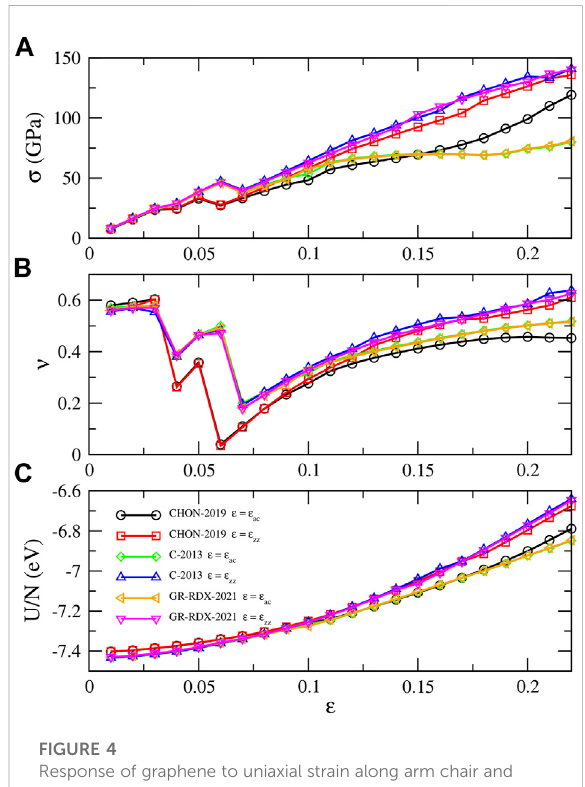
FIGURE 4 Response of graphene to uniaxial strain along arm chair and zig-zag directions. (A) Stress σ , (B) Poisson ’ s ratio ] and (C) energy per atom U / N along the strain direction. The legends of panel (C) applies in all